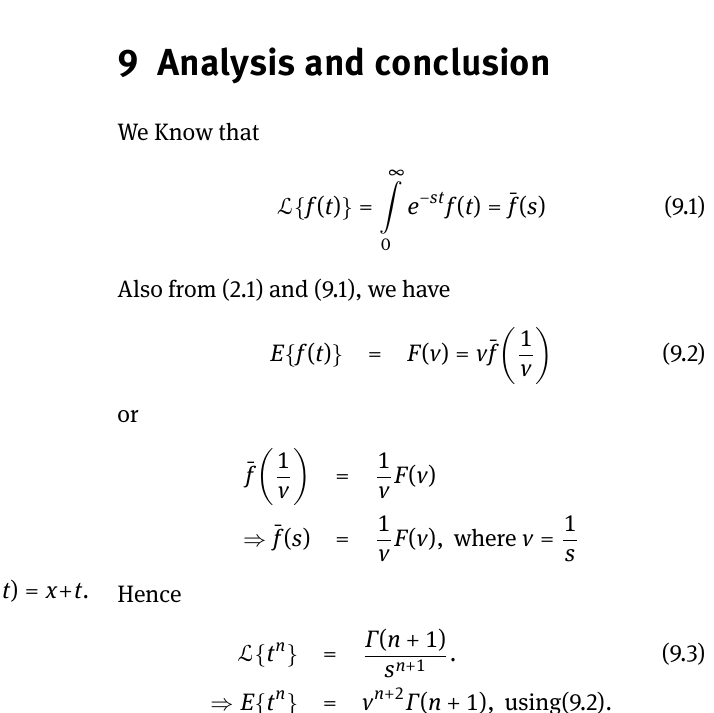
Fig. 15: Plot of of w ( x , t ) of eq. (8.7) when x = 0.5 and α = 0.6, 0.8 and